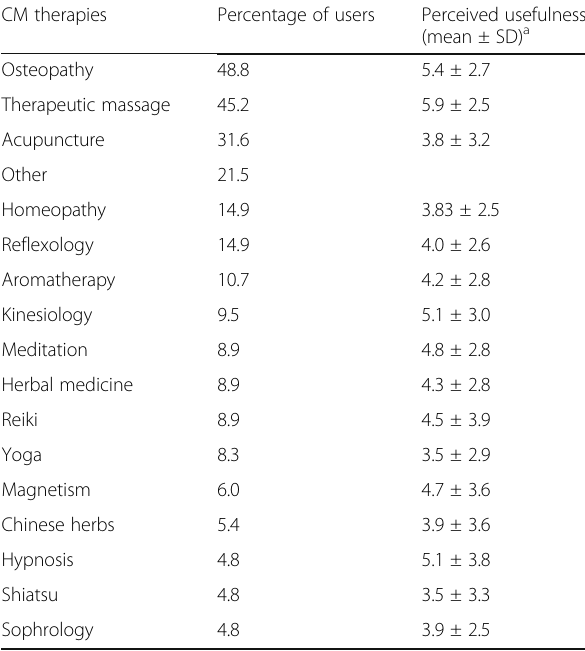
Table 2 Complementary medicine used and its rated usefulness against chronic low back pain CM